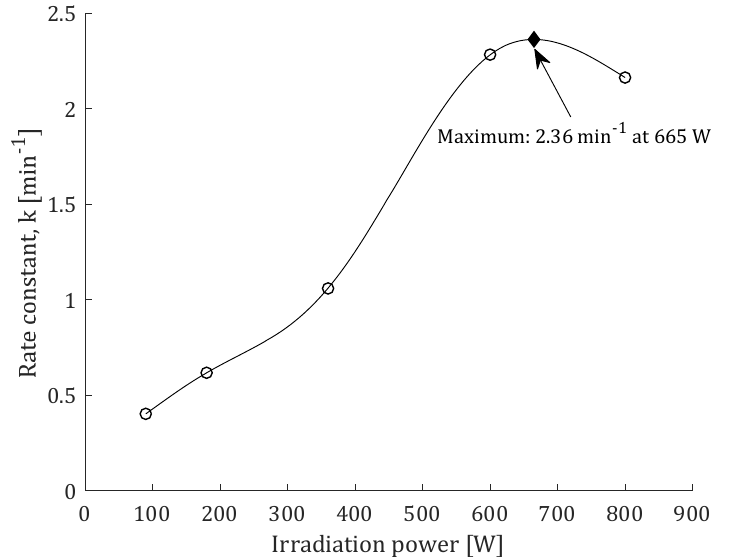
Figure 3. Influence of microwave irradiation power on fitting curves of TP for first-order model.